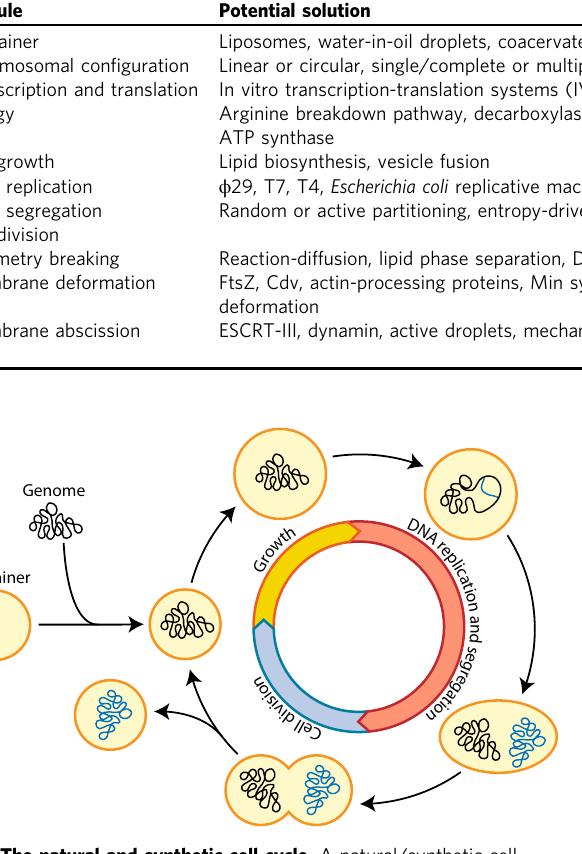
Fig. 1 The natural and synthetic cell cycle. A natural/synthetic cell consists of a genome expressing all essential components inside a container. After a fi rst phase of growth (yellow), the cell enters a phase in which the genomic content is replicated and segregated (red). Finally, cell division happens in the last phase of the cell cycle (blue), generating two daughter cells. Note that, although the fi rst phase of the cell cycle is one of growth, the cell continuously grows also during DNA replication, DNA segregation and cell